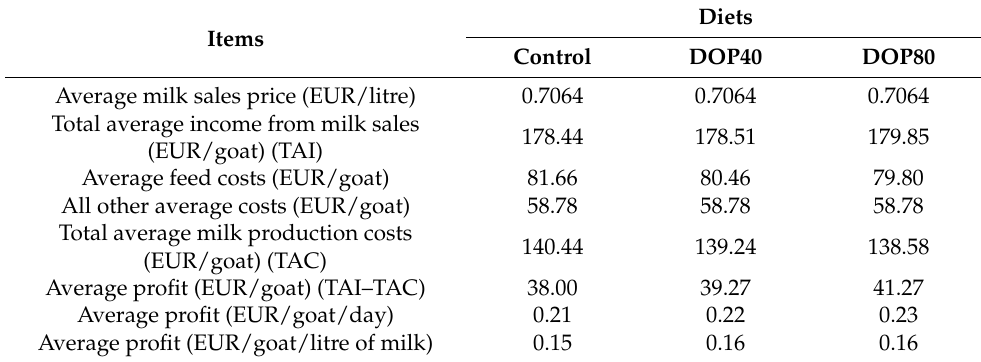
Table 7. Profitability of the different diets throughout